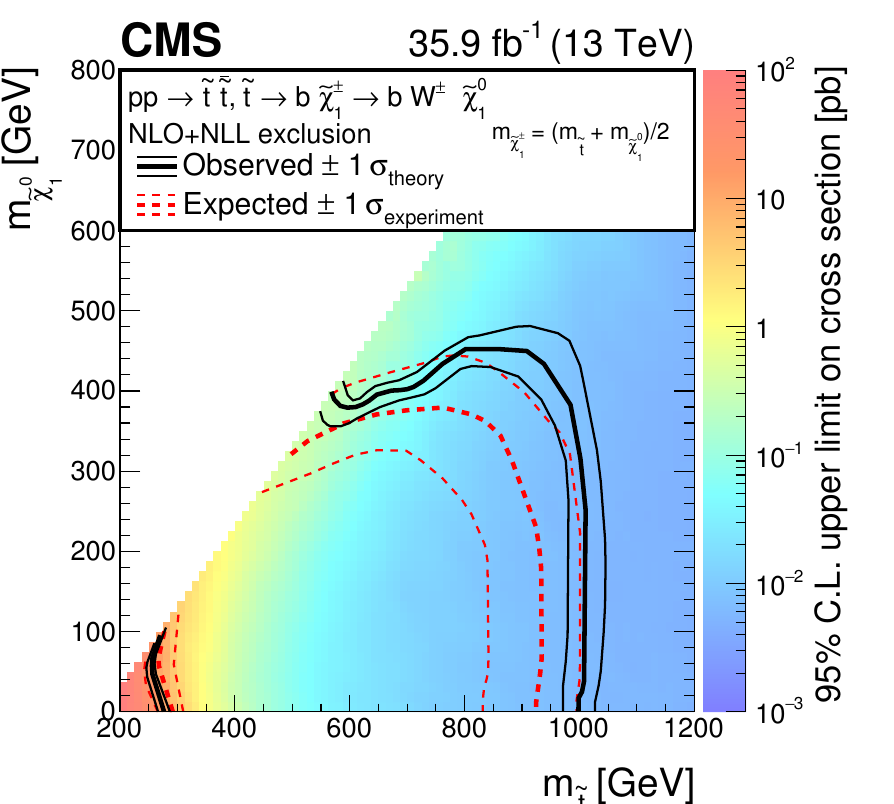
Figure 6 . The exclusion limit at 95% CL for direct top squark pair production with decay ! W b (cid:31) + b (cid:31) (cid:0) , (cid:31) (cid:6) (cid:31) 0 . The mass of the chargino is chosen to be ( m (cid:6) 1 1 1 1 is done in the two-dimensional space of m on the cross section times branching fraction at each point in the m e e e e between the thick black curves represents the observed exclusion region at 95% CL assuming 100% branching fraction, while the dashed red lines indicate the expected limits at 95% CL and their (cid:6) 1 (cid:27) experimental standard deviation uncertainties. The thin black lines show the e(cid:11)ect of the theoretical uncertainties ( (cid:27) theory ) in the signal cross